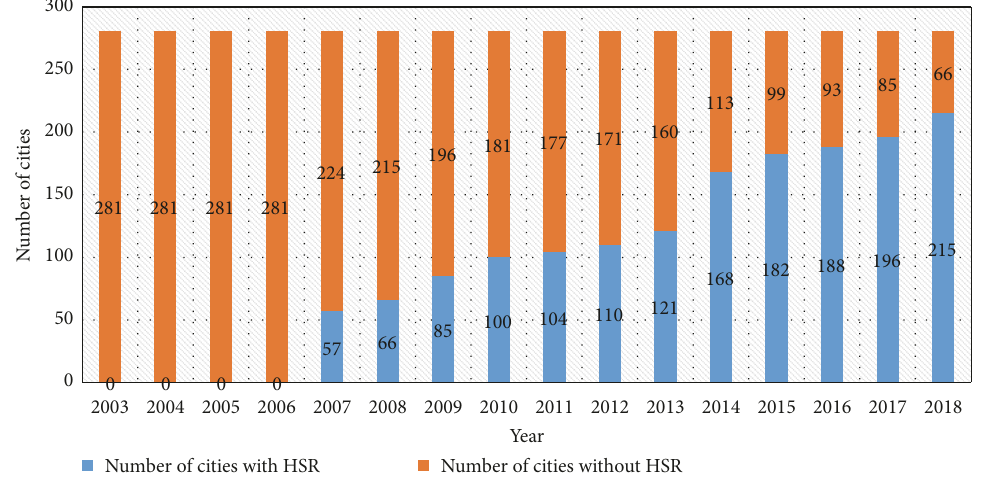
Figure 1: Number of prefecture-level cities with and without